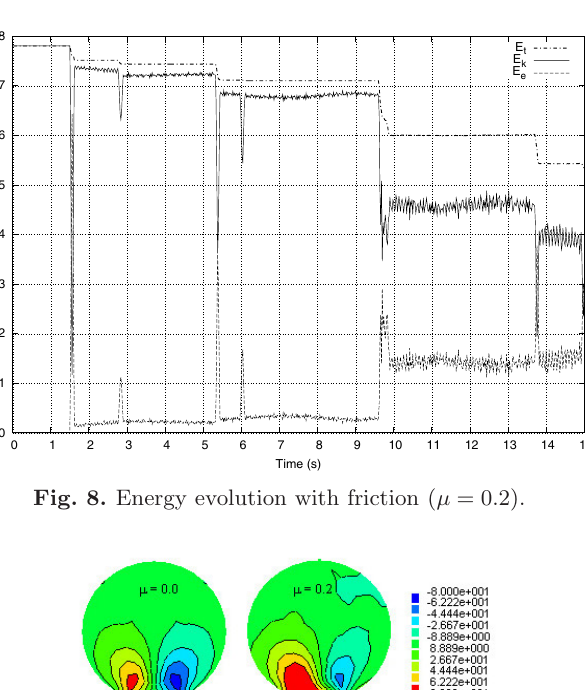
Fig. 7. Energy evolution without friction ( μ = 0 . 0).